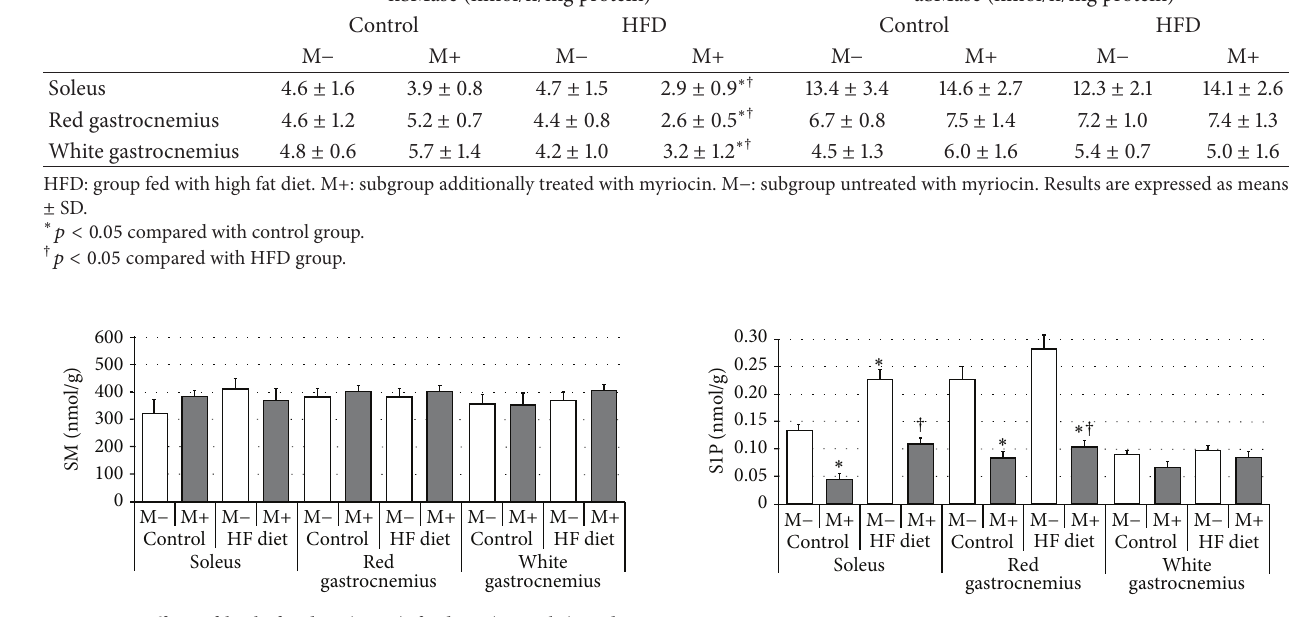
Figure 3: Effect of high-fat diet (HFD) feeding (5 weeks) and/or myriocin application (7 days) on sphingomyelin (SM) content in skeletal muscles ( 𝑛 (per group) = 8). M+: rats administered with myriocin. M − : untreated group. Results are expressed as means ± SD.